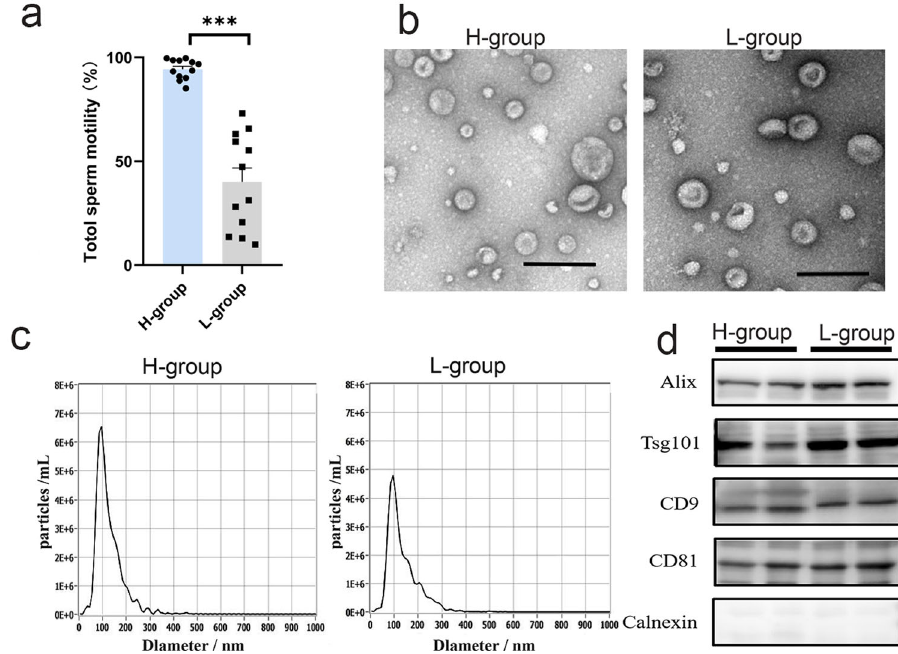
Fig. 1 Isolation and characterization of SPEVs from boars. a The difference in total sperm motility between the two groups. *** P ≤ 0.001 (Student ’ s t test), n = 12 per group. b TEM image of SPEVs. Scale bars: 200 nm. c NTA results showing that the SPEVs were approximately 20 – 300 nm in diameter. d Western blotting results of SPEVs. Alix, Tsg101, CD9, and CD81, which are EV markers, were expressed in isolated SPEVs, and the negative marker Calnexin was not found in our isolated SPEV samples. H-group represents high sperm motility group and L-group represents low sperm motility